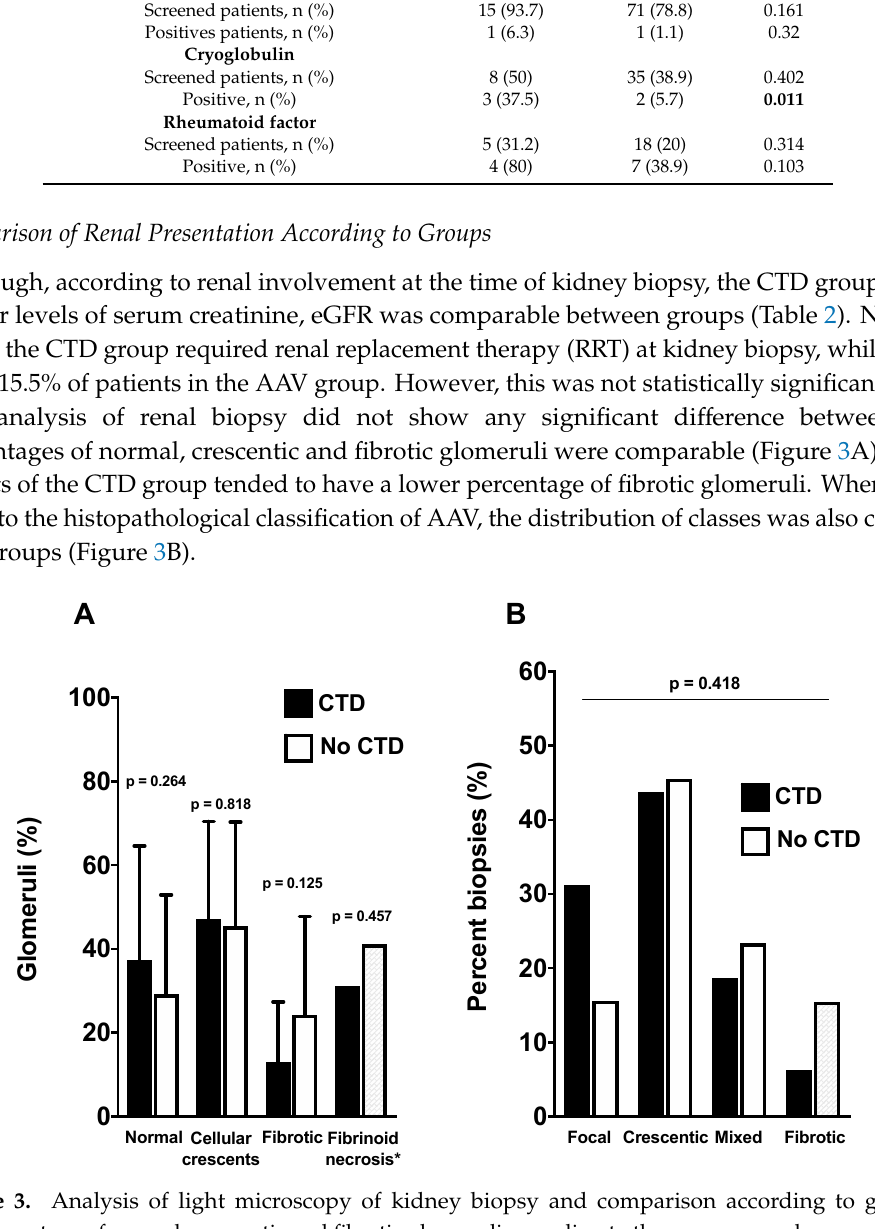
Table 3. Immunological presentation according to groups. Significant p values appear in bold.